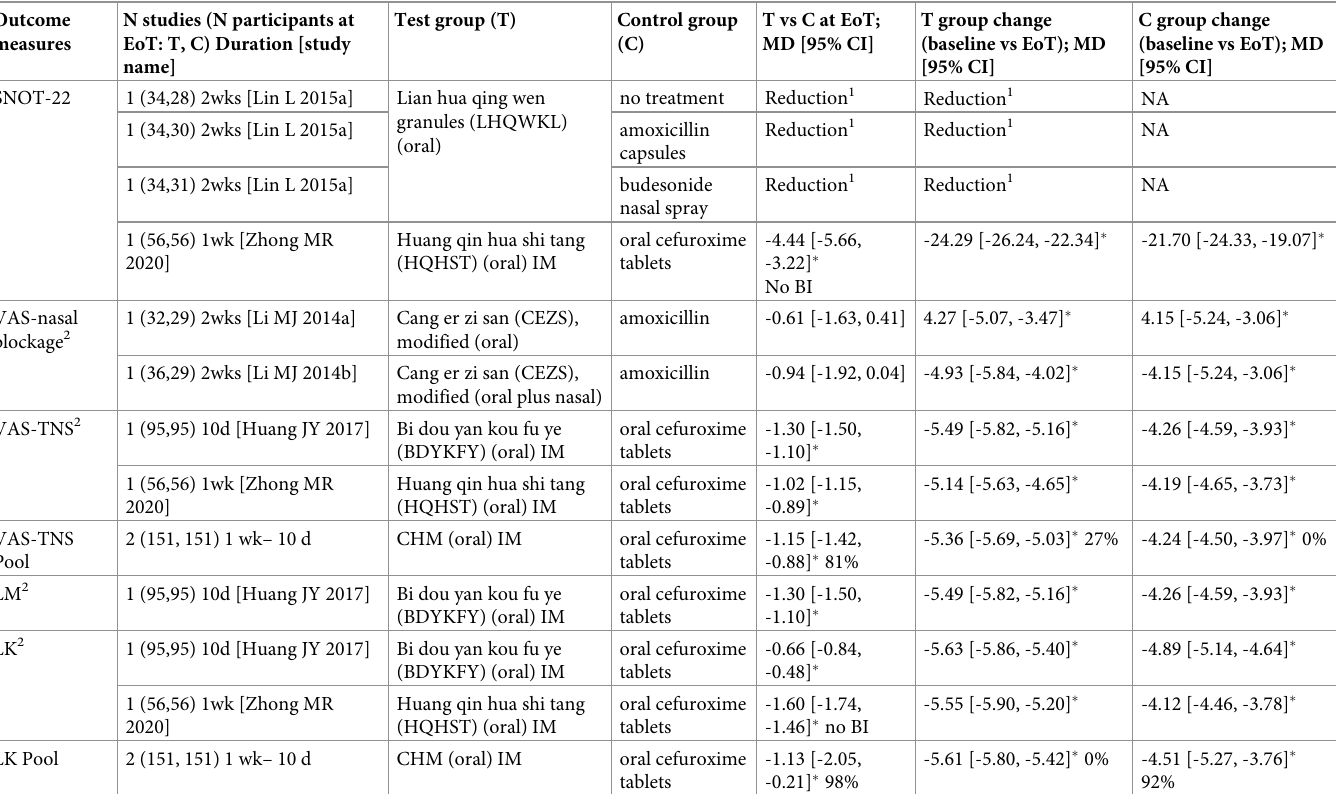
Table 2. Meta-analysis results for acute rhinosinusitis at end of treatment and changes within treatment and control groups. Outcome N studies (N participants at measures EoT: T, C) Duration